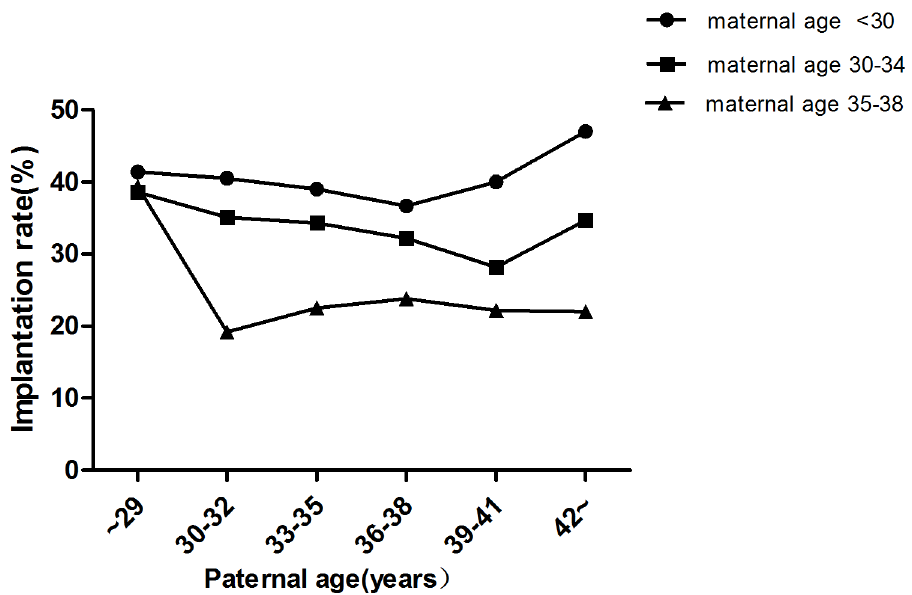
Fig 4. Implantation rates in different age groups. There were no significant differences in implantation rate among the different paternal age groups when the maternal age was < 30 y and 35 – 38 ( P > 0.05). In the 30 – 34 y maternal age group, the implantation rates decreased with increased paternal age ( P <